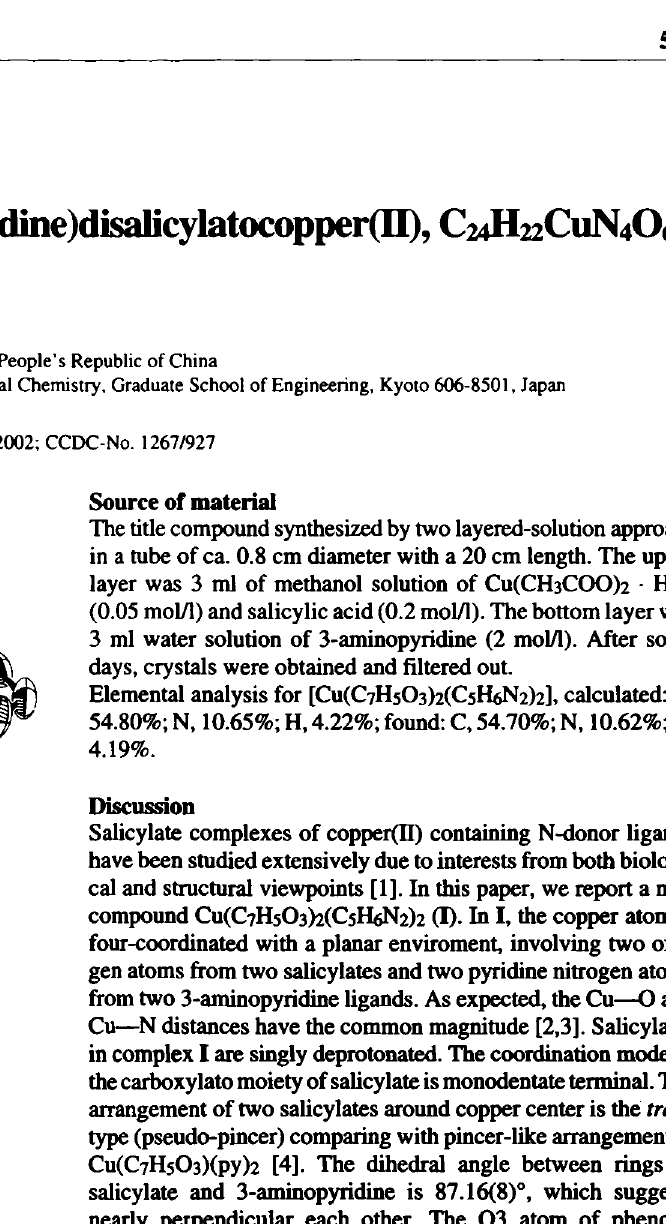
Table 1. Data collection and